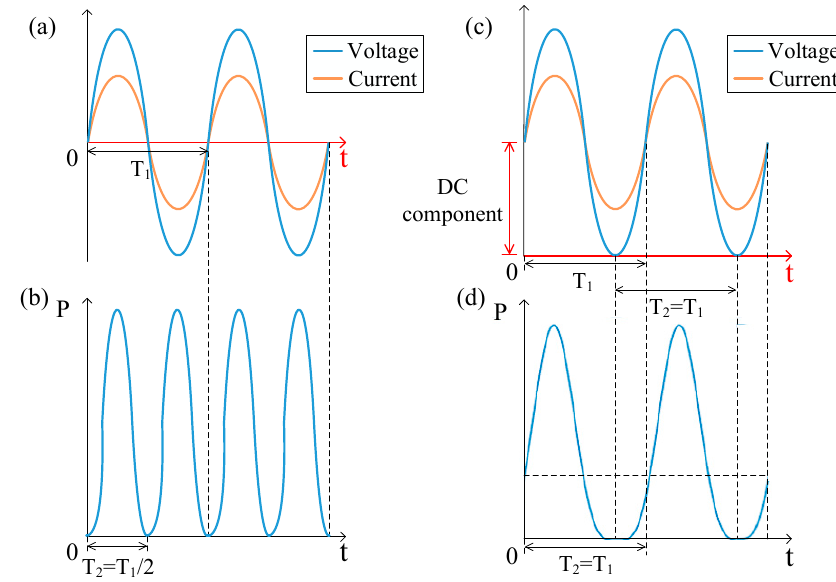
Figure 2. The curves of ( a ) voltage, current and ( b ) electric power under pure AC excitation, and the curves of ( c ) voltage, current and ( d ) electric power under AC and DC excitation. The SPL is determined by the total power P (A+D ) = P1+P2. It can be predicted that the frequency of SPL is mainly determined by the relative magnitude of the single frequency component and the double frequency component of total electric power. The principle of suppressing the frequency doubling effect is shown in Figure 2c,d. The frequency dou- bling effect can be neglected when a large DC is applied. In order to study the method to suppress the frequency doubling effect, we investi- gated the relationship between DC and AC. Keeping AC = 5 V, the DC amplitude was studied in three cases: (1) less than the AC amplitude; (2) equal to the AC amplitude; (3) greater than the AC amplitude. Firstly, we investigated the case that the amplitude of DC is less than that of AC. The AC excitation is shown in Figure 3a, that is, the single frequency curve. The electric power under pure AC excitation is shown in Figure 3b, that is, the double frequency curve. With the increasing of DC bias (as shown in Figure 3c DC = 1 V and Figure 3d DC = 3 V), it is obvious that the frequency doubling effect is gradually suppressed. However, as long as the DC amplitude is less than the AC amplitude, the frequency doubling effect will still exist.